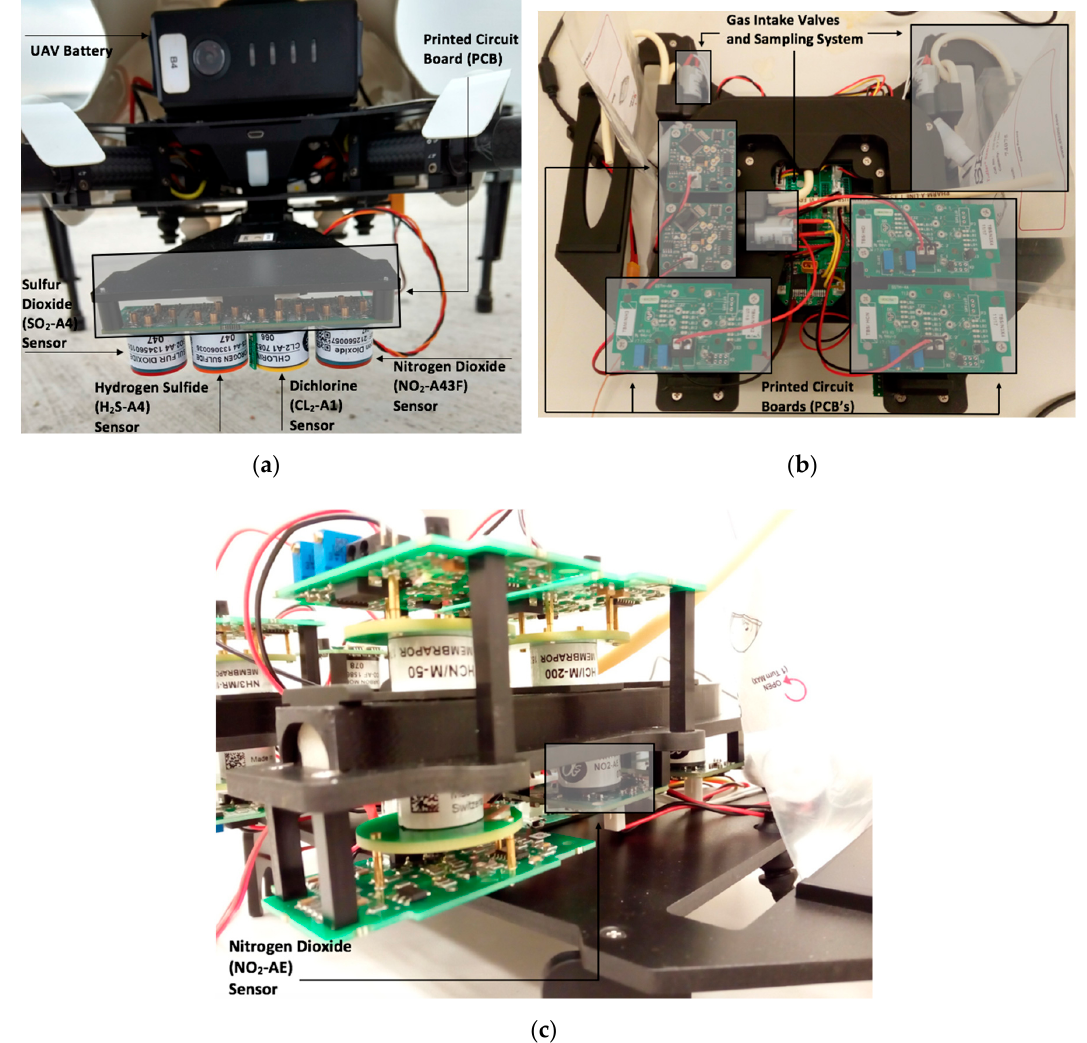
Figure 2. ( a ) UAV mount for the NO 2 -A43F system setup; ( b ) top of UAV mount for the NO 2 -AE setup; ( c ) side of UAV mount for the NO 2 -AE setup.